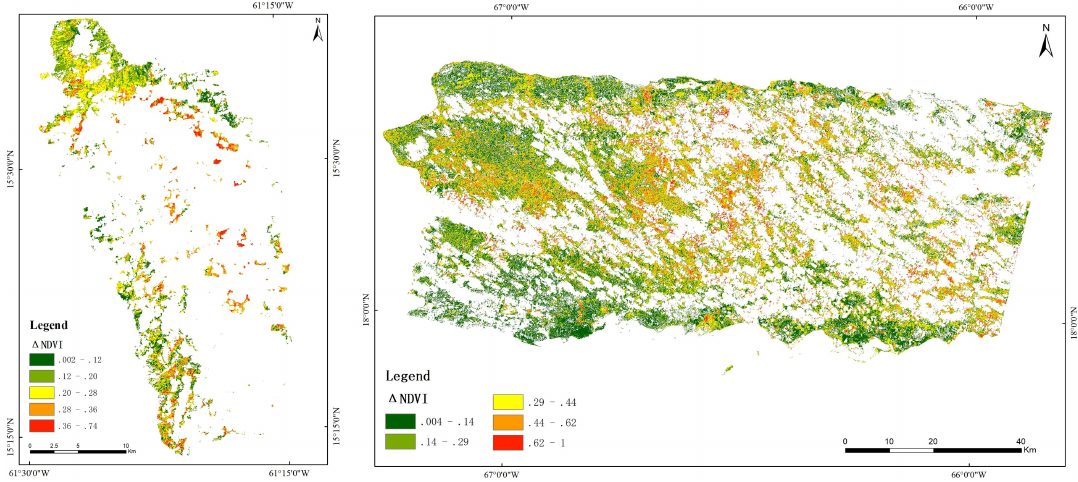
Figure 3. Spatial distribution of ∆ NDVI. ( a ) Dominica (pre-hurricane: 09/09/2017, post-hurricane: 09/21/2017); ( b ) Puerto Rico (pre-hurricane: 09/17/2017, post-hurricane: 10/03/2017).